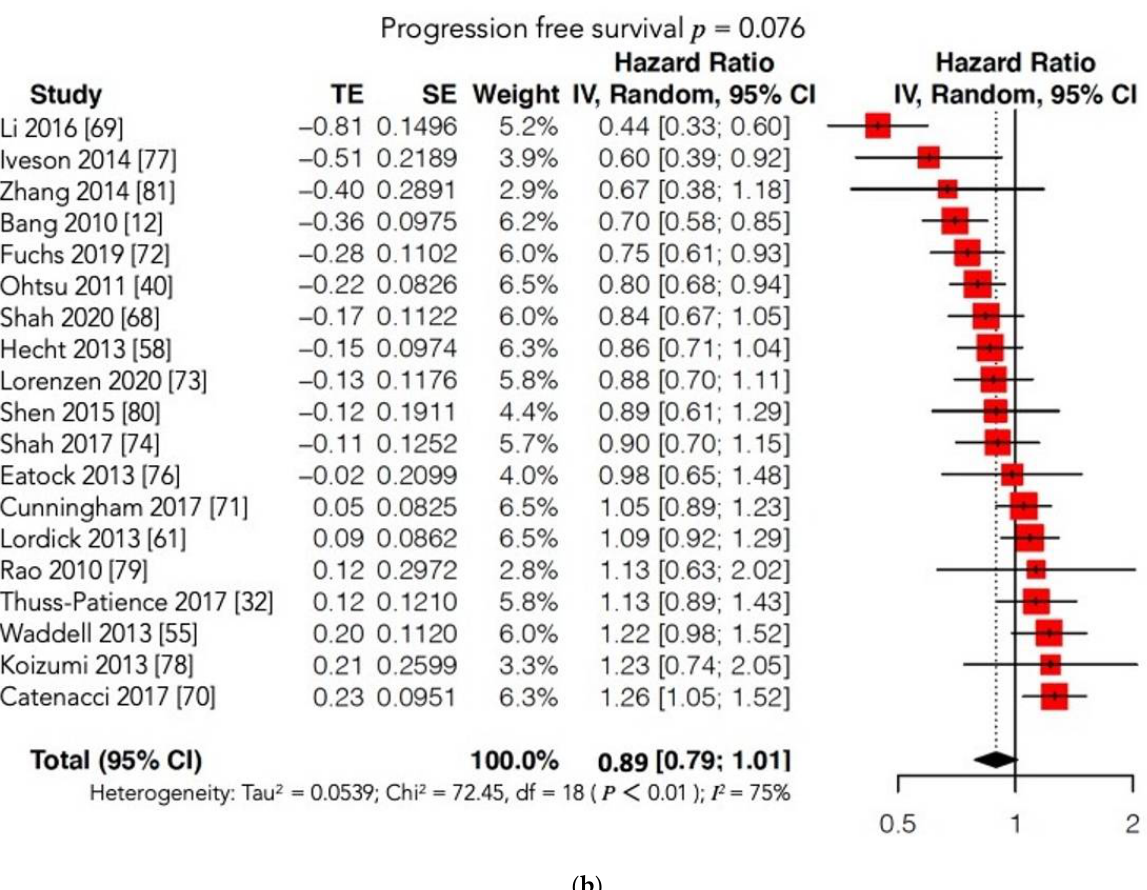
Figure 7. ( a ) Forest plot of comparison: molecular-targeted therapy alone/plus chemotherapy versus chemotherapy alone/placebo. Main analyses; outcome: overall survival (data from Cochrane and present review pooled). ( b ) Forest plot of comparison: molecular-targeted therapy alone/plus chemotherapy versus chemotherapy alone/placebo. Main analyses; outcome: progression free survival (data from Cochrane and present review pooled).